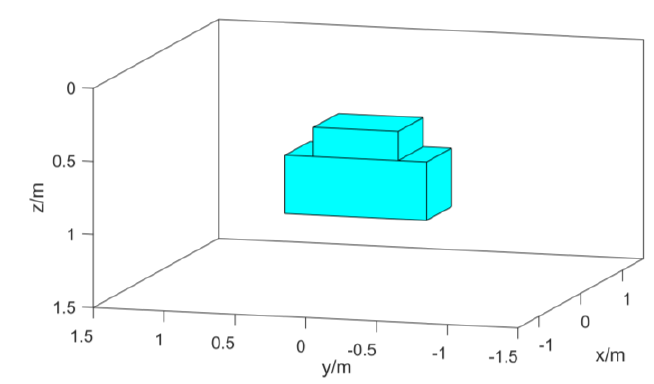
Figure 9. Schematic diagram of the isolated model. The model simulation data are added with Gaussian white noise of 5% of the reference value to simulate the data in the actual environment. The normalized magnetic source strength and total magnetic field data of the simulation data are shown in Figure 10.